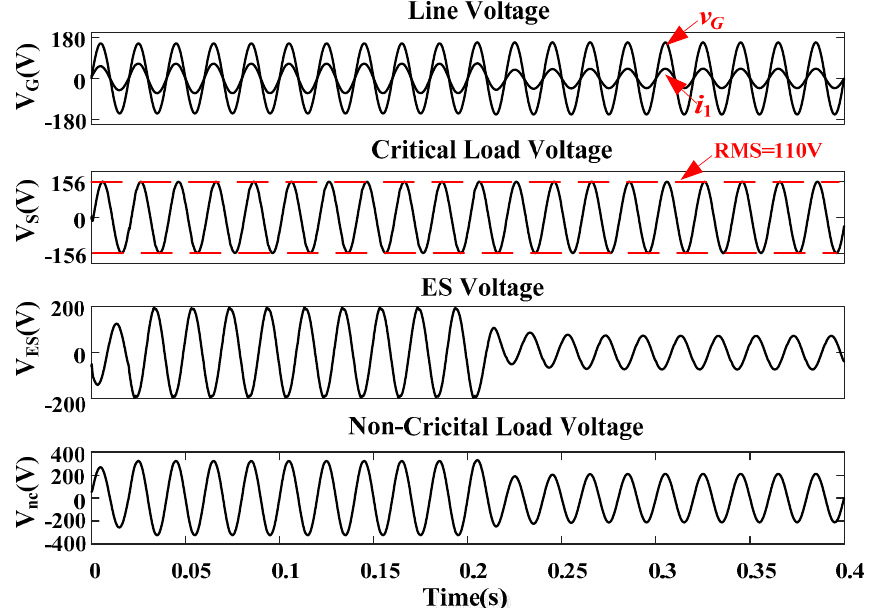
Figure 8. The simulation waveforms based on dead-beat and δ control under the power factor correction (PFC) mode.